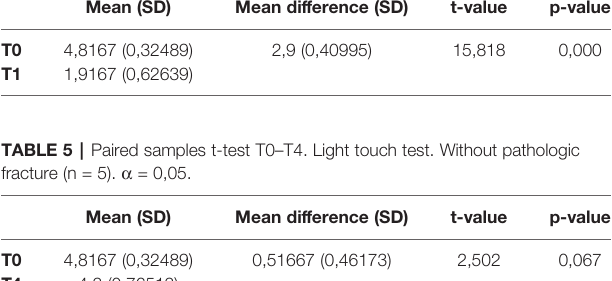
TABLE 4 | Paired samples T-test between T0 and T1 for objective IAN function in patients without a pathologic fracture (n = 5). a = 0,05. Mean (SD) Mean difference (SD)